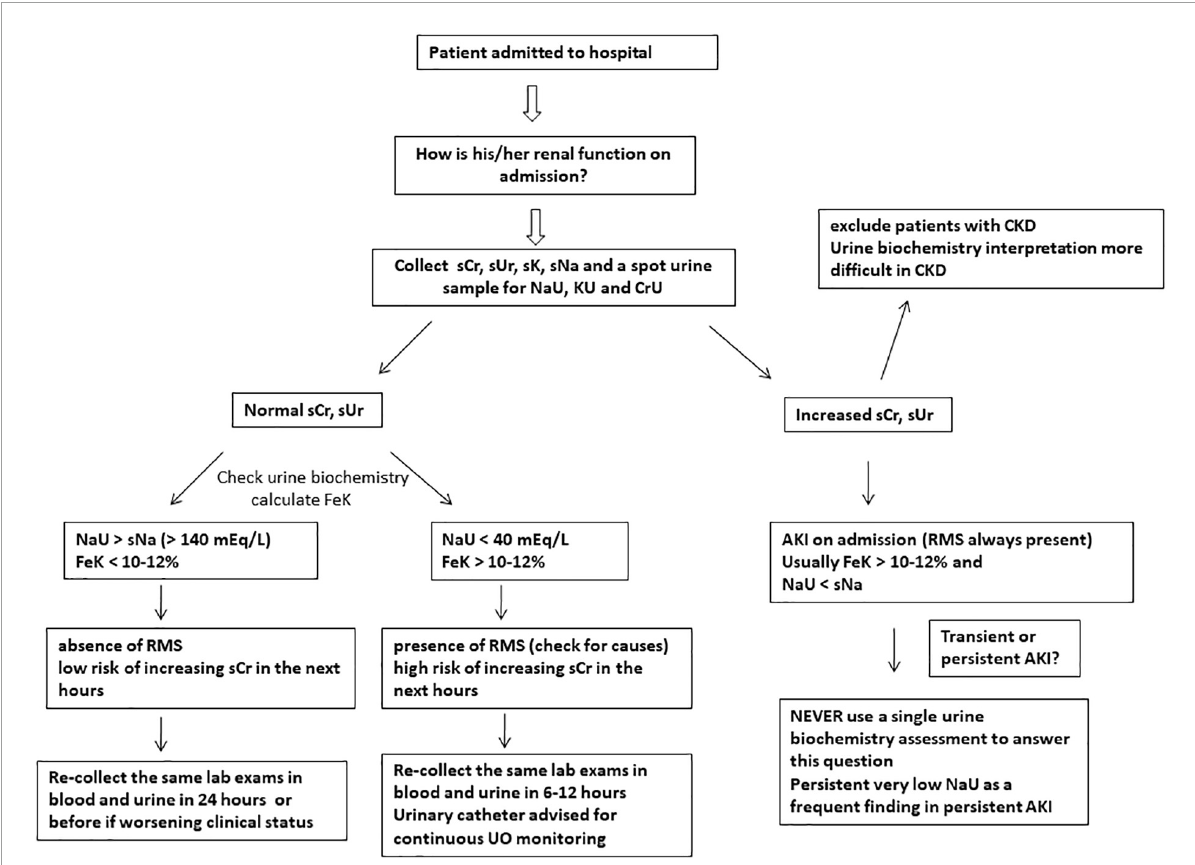
FIGURE2 Suggested approach to evaluate renal function at hospital/ICU admission using simple and feasible blood and urinary parameters. Urine sodium concentration (NaU) values between 40 and 140 mEq/L are of uncertain significance when measured at a single time point and should be obtained sequentially. Abrupt decreases in NaU suggest renal microcirculatory stress (RMS) development and risk of acute kidney injury (AKI). SCr, serum creatinine; sUr, serum urea; sNa, serum sodium; sK, serum potassium; KU, spot urine potassium concentration; CrU, spot urine creatinine concentration; FeK, fractional excretion of potassium; UO, urine output; CKD, chronic kidney